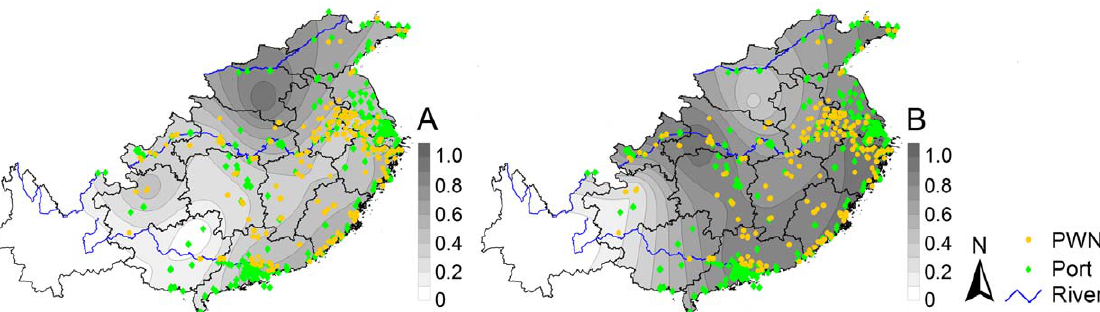
Figure 4. Contour mapping ofthe ratio of shared haplotypes ( R shr ) (A) and the haplotype diversity ( D hap ) (B) with the distribution of pinewood nematode (PWN) infested sites (yellow dots as of 2012) and ports (green dots) within the research study area in China (as calculated at the provincial level).